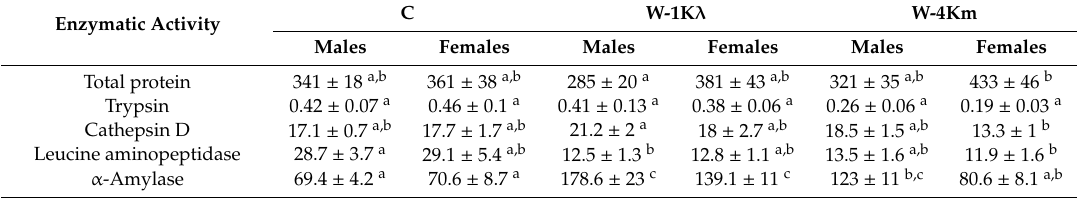
Table 3. Total protein and digestive enzymatic activities of adult male and female flies from lambda-cyhalothrin-resistant W-1K λ , the susceptible C, and the malathion-resistant W-4Km strains of C. capitata . Enzymatic